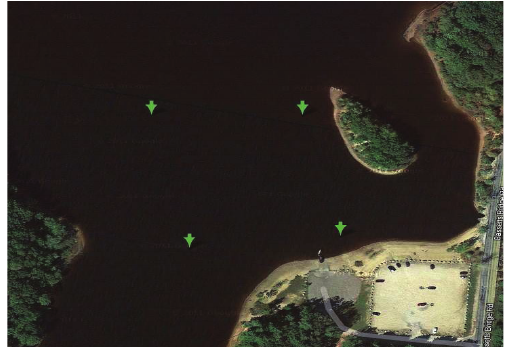
Figure 14: Approximate node deployment of August 2011 test via Google Maps.